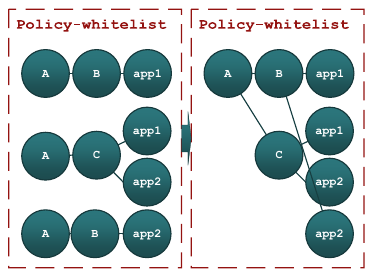
Figure 2. Tree mergers of config in the